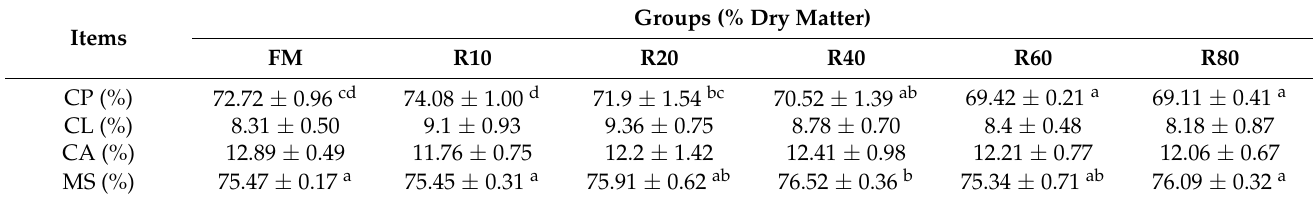
Table 5. Effects of RPM replacing fishmeal on whole body composition for L. vannamei .